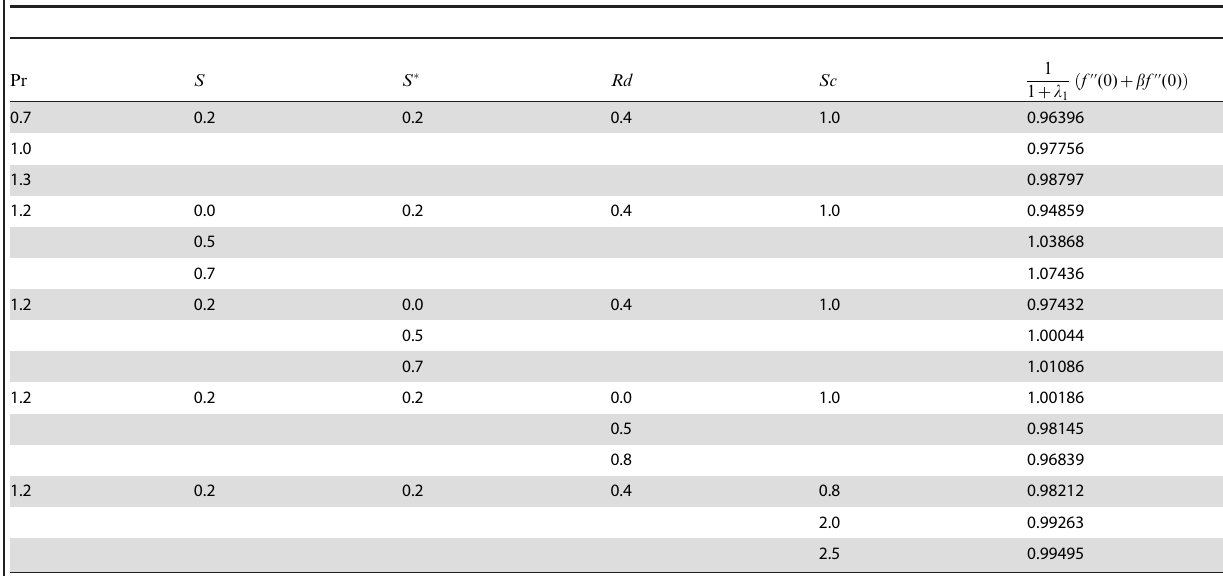
Table 3. Values of skin-friction